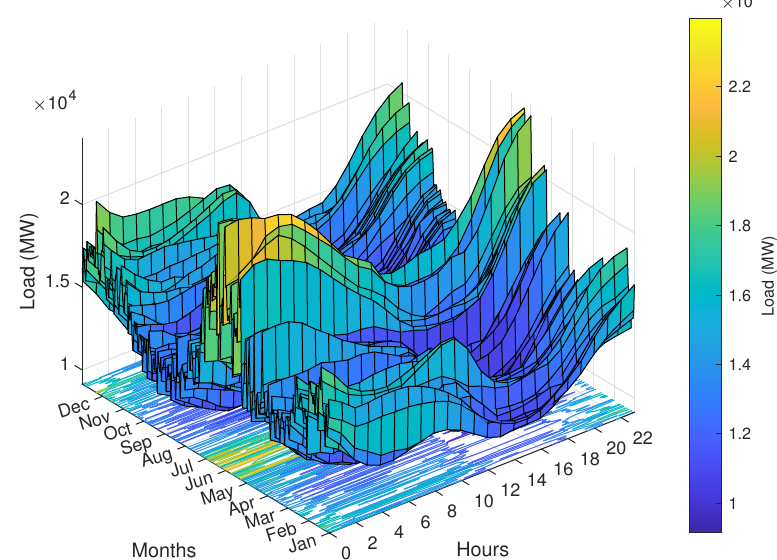
Figure 4. New England region (US) 2016 Load